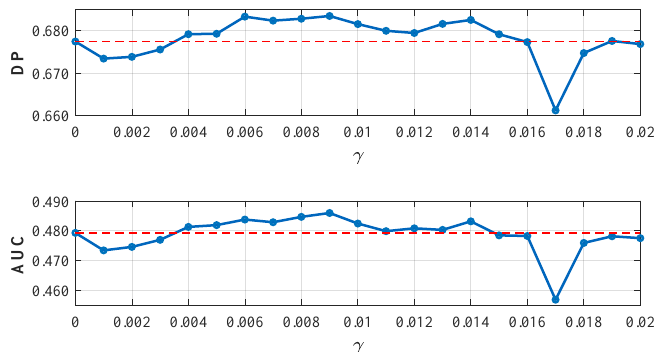
Figure 9. Average performance on three benchmarks when the context regularization parameter γ varies from 0 to 0.02. Top : the curve of AUC score. Bottom : the curve of DP score.